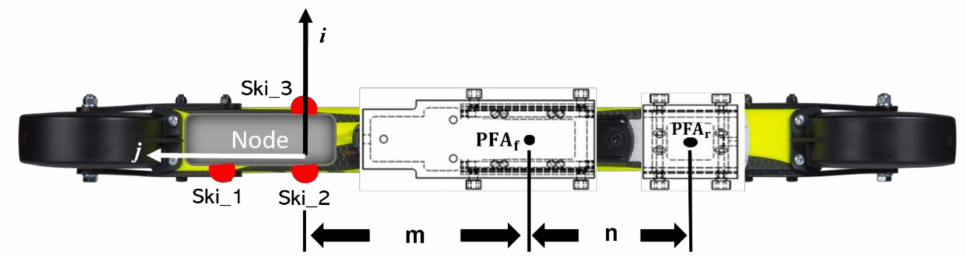
→ → → Figure 3. Displacement of markers, PFAs, and the definition of FCS ( i , j , k). Three markers (Ski_1, Ski_2, and Ski_3) were attached to the side of the node. The node for power supply and data transmission was attached to the front part of the roller ski. The surface defined by the markers was → → parallel to the roller ski surface. i was defined by Ski_3 and Ski_2. Another unit vector ( r ) located → on the surface of the roller ski was defined by Ski_1 and Ski_2. The surface norm, which was the k of → → → FCS, was the cross product of i and r . The last unit vector j was computed by using the right-hand → → rule with k and i . The PFA f and PFA r were the points of force application of the front and rear sensors, respectively. The distance between Ski_2 and PFA f was m , and the distance between PFA f and PFA r was n